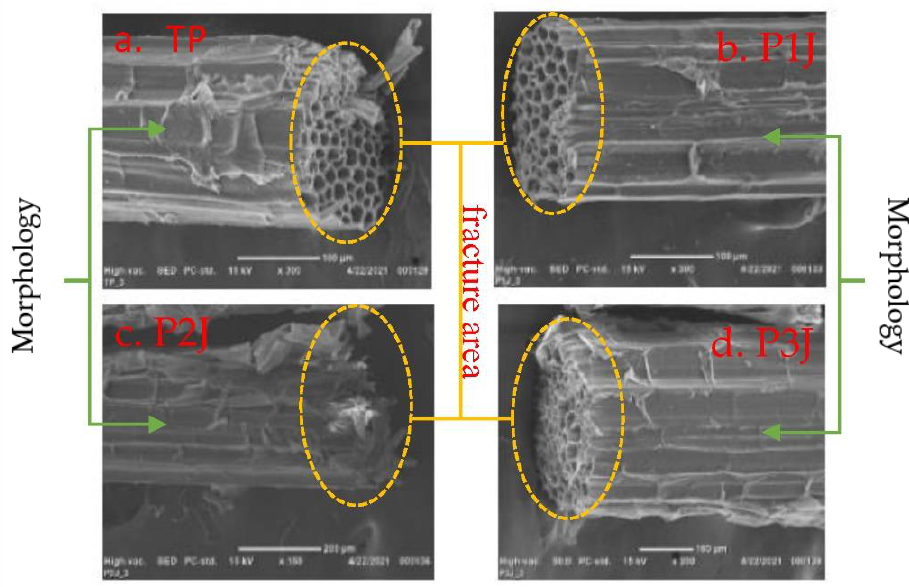
Figure 4. The surface of BSFs with SEM Photo of TP, P1J, P2J and P3J.